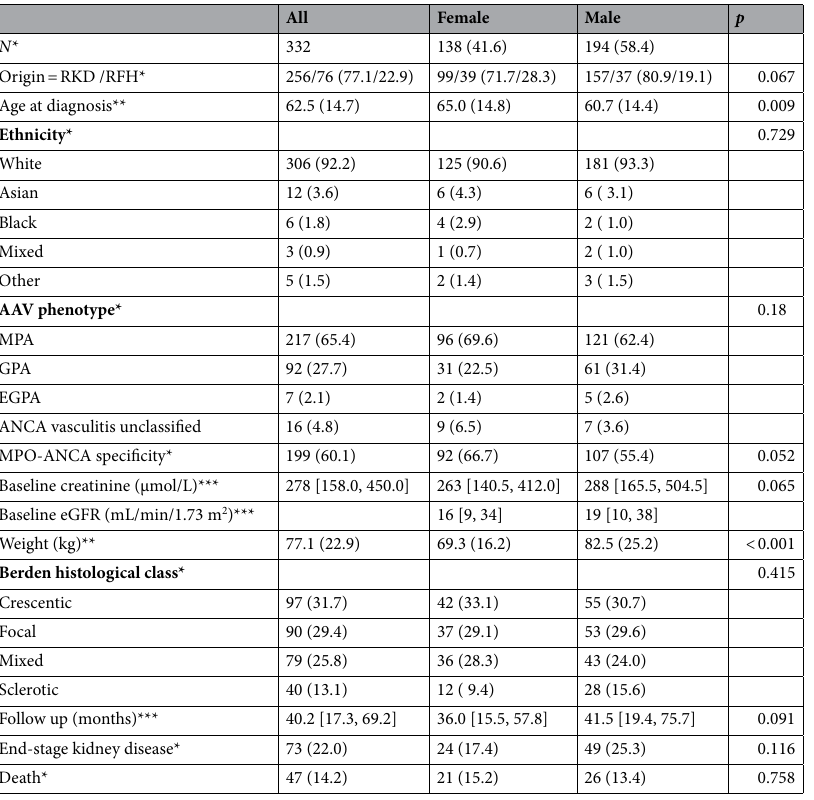
Table 1. Baseline characteristics in the total cohort and stratified by sex. Missing data: baseline creatinine for females (n = 20), males (n = 27), weight for females (n = 20), males (n = 23). Rare Kidney Disease Registry (RKD), Ireland. Royal Free Hospital (RFH), London, U.K. Microscopic polyangiitis (MPA), Granulomatosis with polyangiitis (GPA), Eosinophilic granulomatosis with polyangiitis (EGPA), Estimated Glomerular Filtration Rate (CKD-EPI, eGFR) was calculated from baseline creatinine. *Frequency (%). **Mean (standard deviation). ***Median (inter-quartile